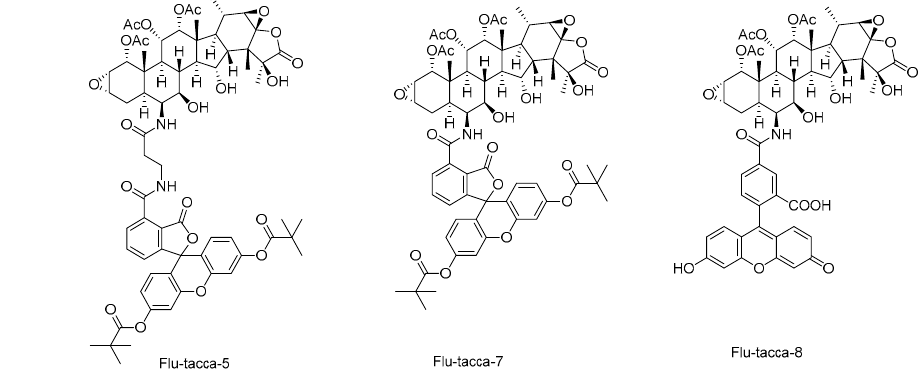
Figure 6. The selective structures of taccalonolide probes. Table 4. Antiproliferative potencies of taccalonolides [15,18,39,42].